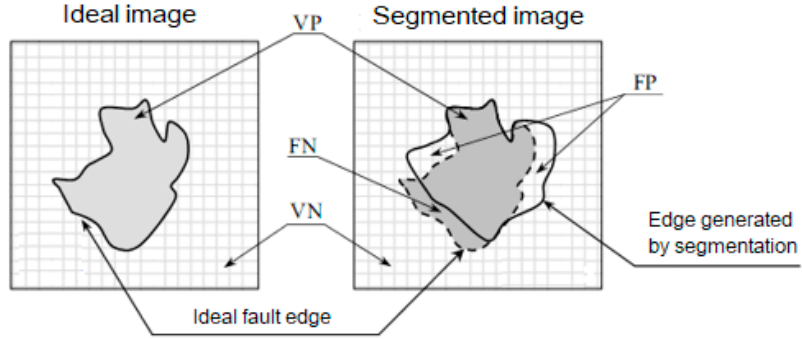
Figure 14. Representation of the differences between ideal and segmented images.